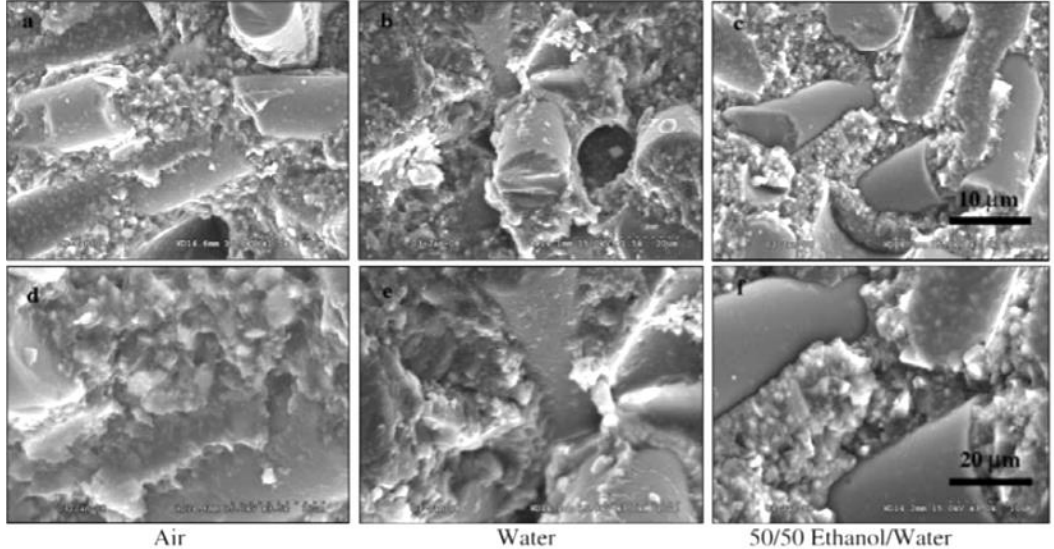
Figure 2. SEM micrographs of the fracture surface of short-glass-fiber-reinforced resin composites aged for 6 months in three different media: ( a , d ) air; ( b , e ) distilled water; and a ( c , f ) 50:50 ( v / v ) mixture of ethanol and distilled water. The images indicate the relatively large sizes of the fiber fillers compared with the surrounding particle fillers and the separation of the fiber fillers from the resin matrix in ethanol/water ( c , f ) compared with the other media. Images from [41].